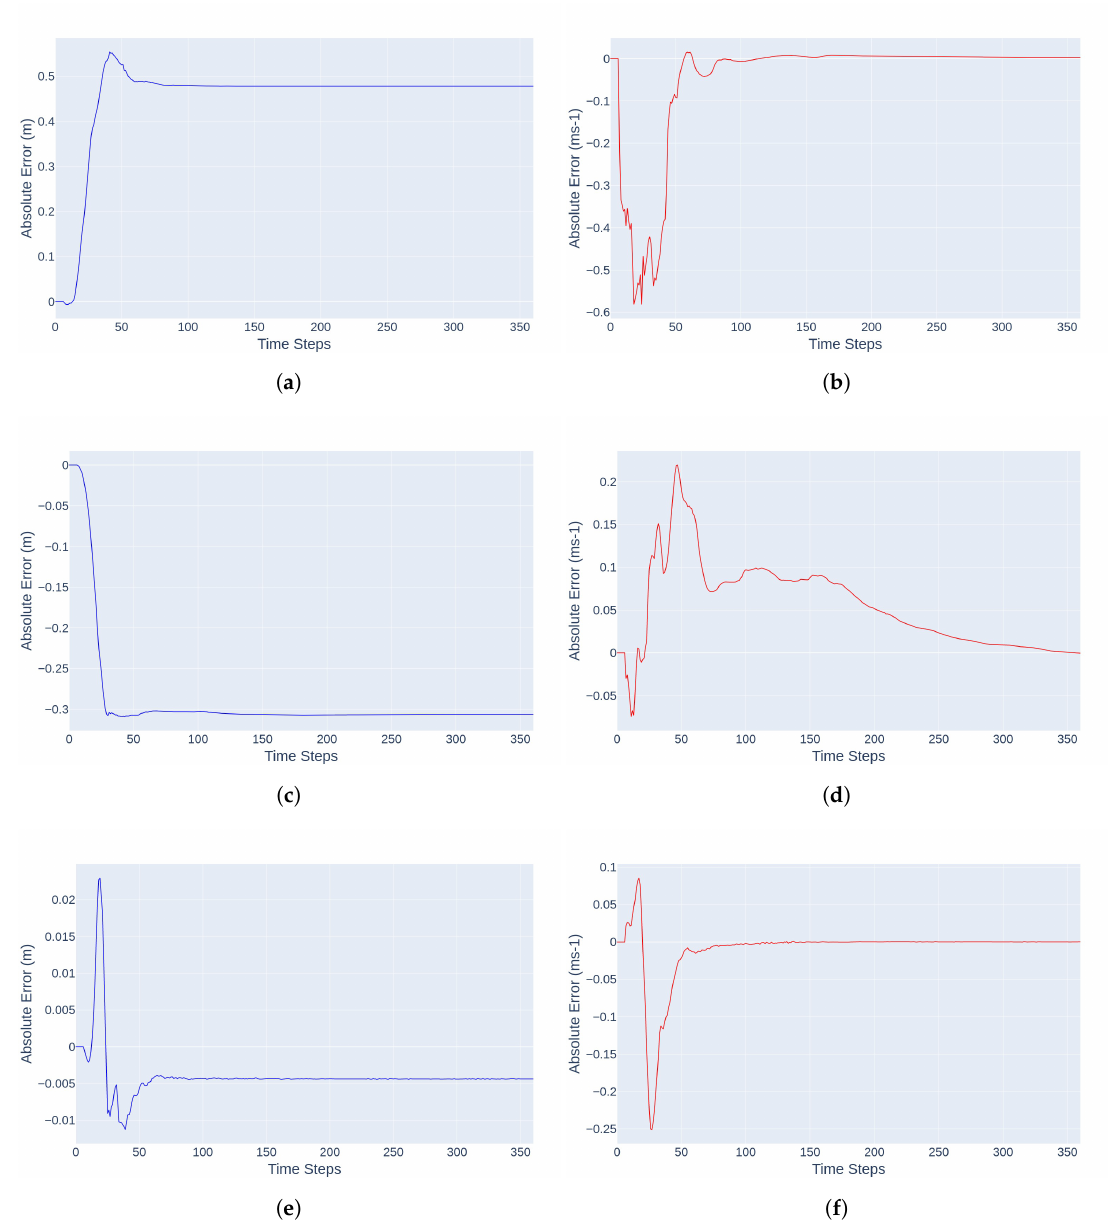
Figure 10. Residual plots (ANUGA-CAMC) for water depth ( left ) and velocity ( right ): ( a , c , e ) Water depth at gauges 4–6; ( b , d , f ) Velocity at gauges